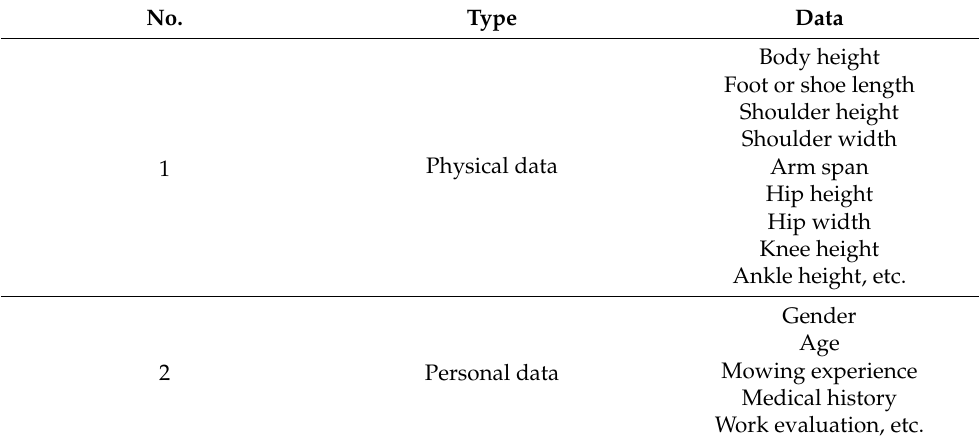
Table 4. Details of physical and personal measures for analysis.